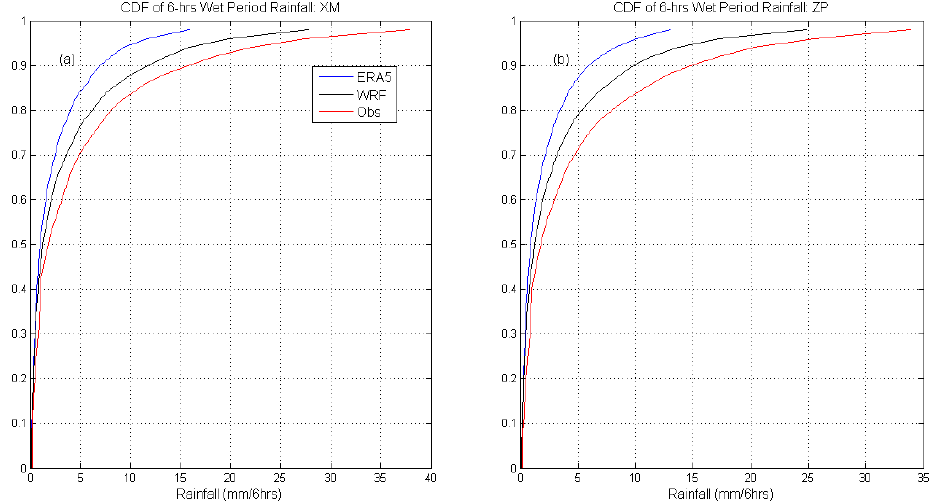
Figure 15. The rainfall intensity empirical cumulative distribution functions (ECDFs) (covering the range of 0–98%) comparing 6-hour wet period model outputs with observations: ( a ) XM; ( b ) ZP.